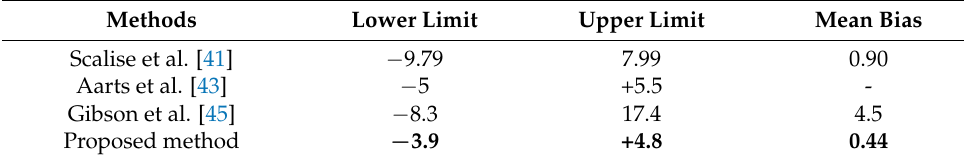
Table 1. Comparison of Bland–Altman data for